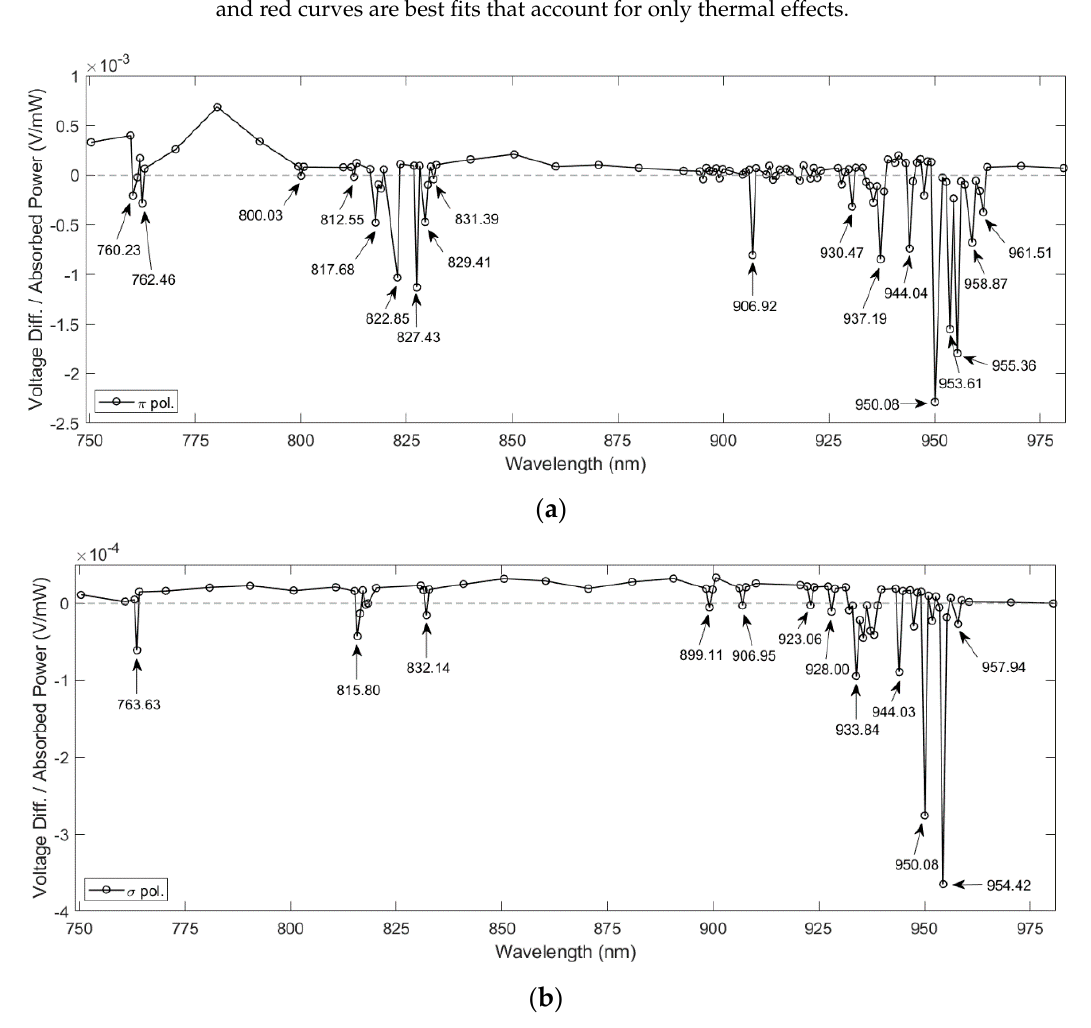
Figure 15. TLS signal versus wavelength in Ti:Al 2 O 3 for ( a ) 𝜋 -polarization and ( b ) 𝜎 -polarization. Positive signals correspond to heating; negative signals correspond to net cooling of the sample. Wavelength tuning was not continuous but proceeded in ~0.3 nm steps.